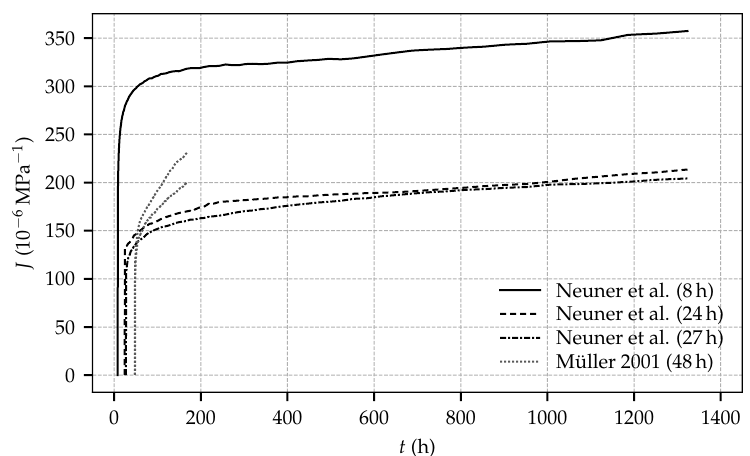
Figure 8. Compliance functions determined from the creep tests of the present experimental program, started at shotcrete ages of 8 h, 24 h and 27 h, and compliance functions from creep test series 4/2, conducted on two specimens by Müller, started at the shotcrete age of 48